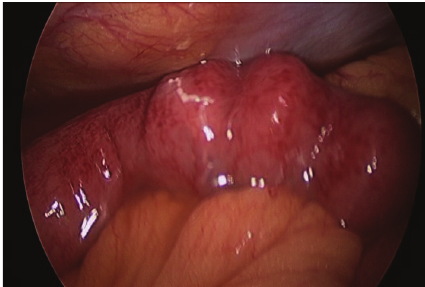
Figure 2: The entire small intestine appeared red and showed